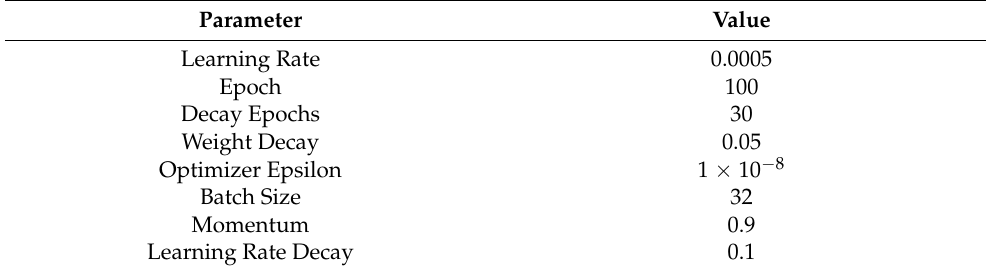
Table 1. Training parameter